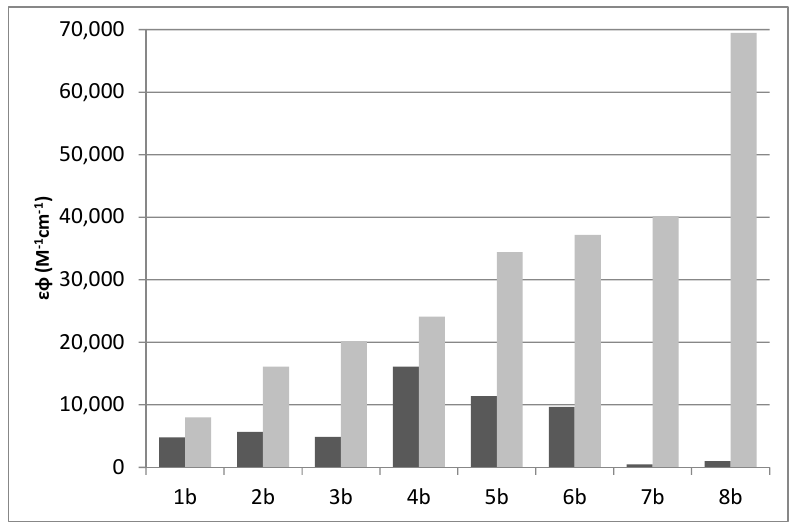
Figure 1. Brightness of the chelates 1b – 8b in 0.05 M TRIS buffer (dark grey) and on a dried surface (light grey).